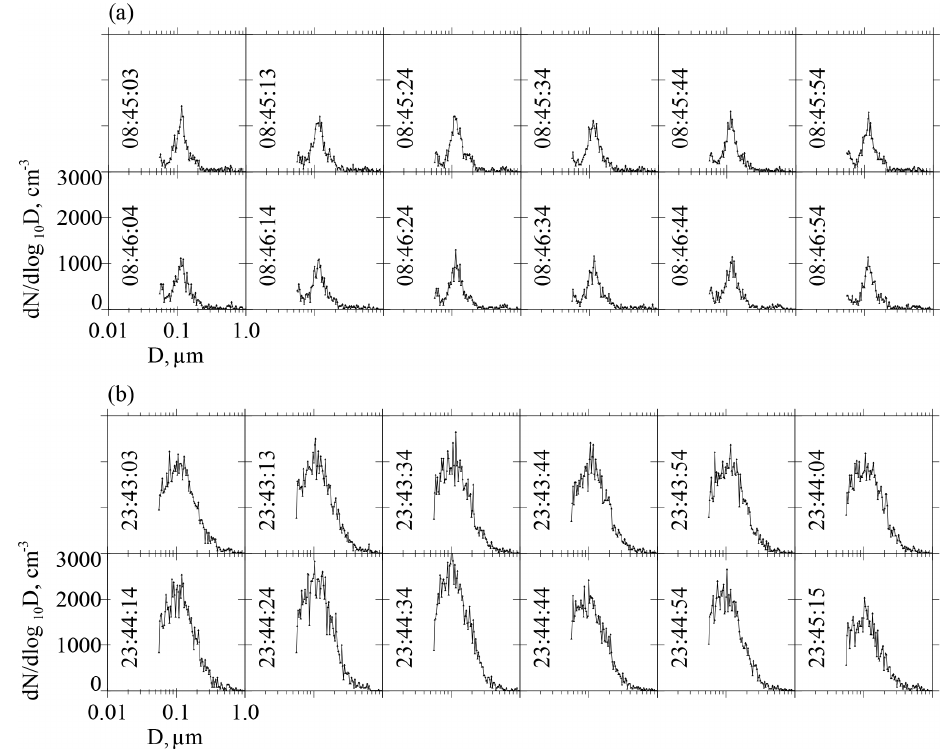
Figure 4. Consecutive ASDs recorded by the UHSAS at the Arauco site. (a) ASDs with a relatively small concentration ( ∼ 300cm − 3 ), a right tail of an Aitken mode (at ∼ 0 . 06µm), and an accumulation mode (at ∼ 0 . 1µm), in onshore-moving air on 5 June 2015. (b) ASDs with a proportionately larger concentration ( ∼ 1100cm − 3 ), an accumulation mode (at ∼ 0 . 1µm), and no evidence of an Aitken mode, in air thought to be contaminated by continental sources (4 June 2015). Time is written in UTC in each